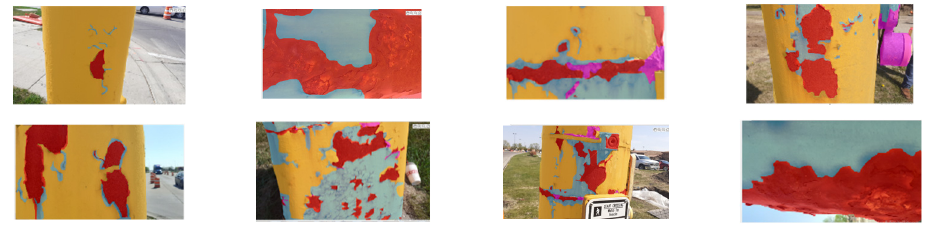
Figure 5. Annotated Images.